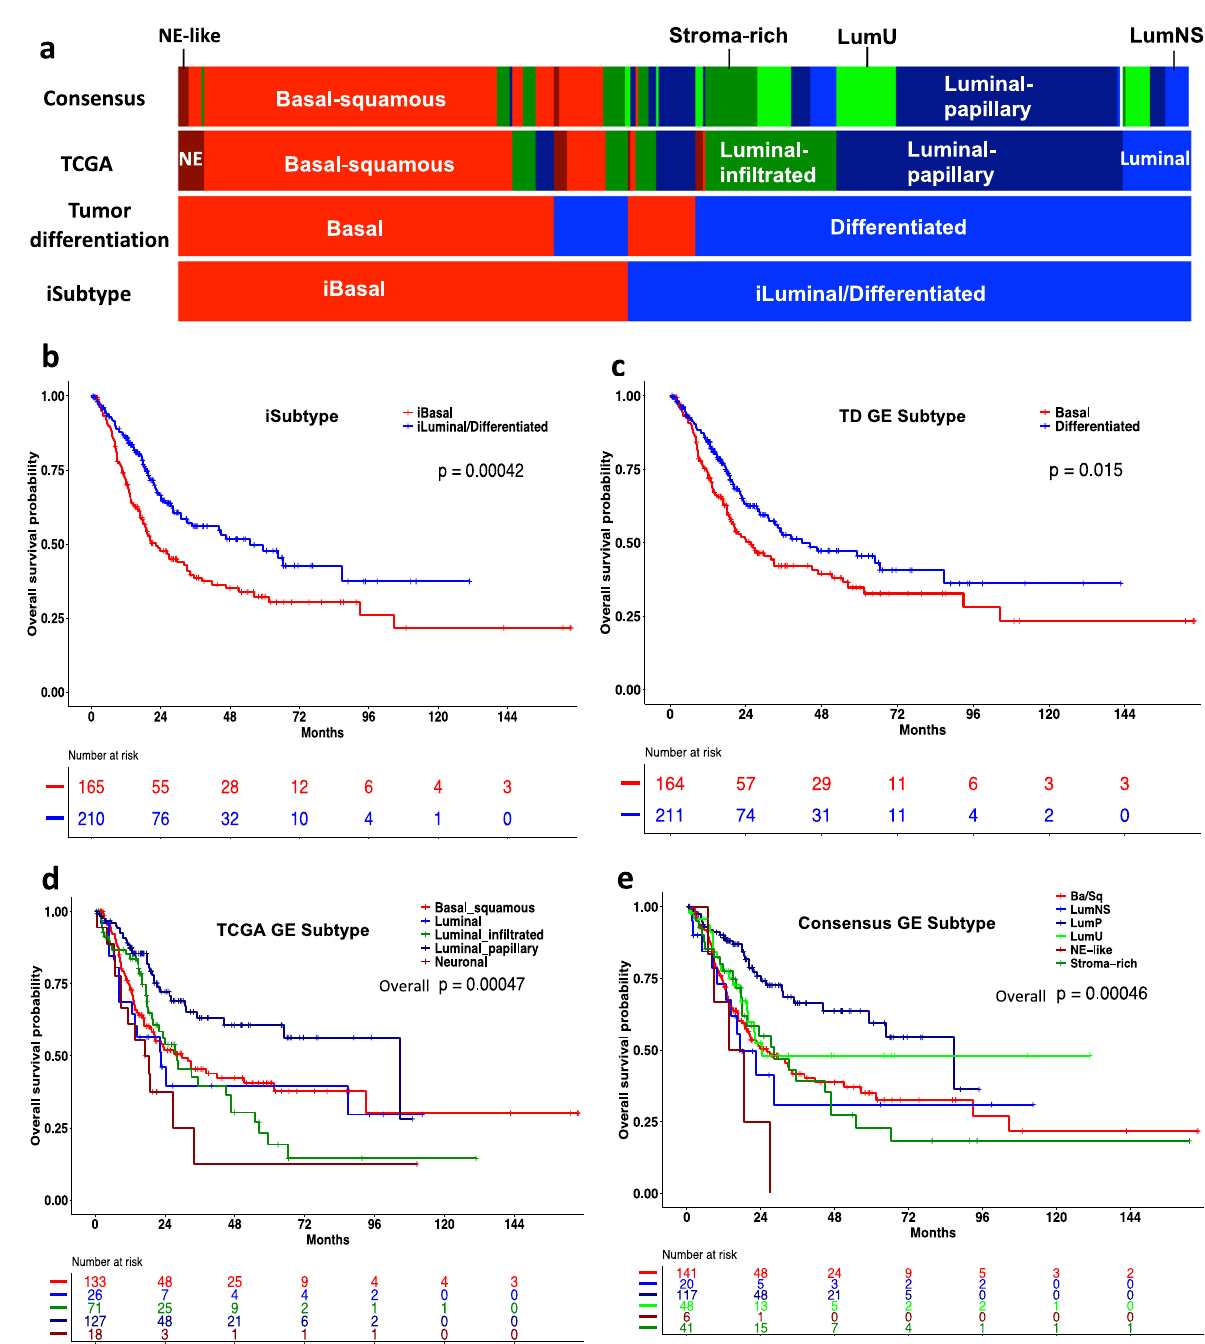
Fig. 2 Comparison of iSubtypes with other GE based subtypes in the TCGA cohort. a TCGA samples ( n = 388) colored according to the iSubtypes, TD, TCGA, and consensus GE subtypes, respectively. b Patient overall survival strati fi ed by iBasal and iLuminal/Differentiated subtypes. c Patient overall survival strati fi ed by the basal and differentiated subtypes de fi ned by the TD GE signature. d Patient overall survival strati fi ed by the TCGA GE subtypes. Luminal_papillary vs. the others: p < 0.0001. NE = neuronal. e Patient overall survival strati fi ed by the consensus GE subtypes. LumP vs. the others: p < 0.0001. Ba/Sq: basal/squamous; LumNS = luminal nonspeci fi ed; LumP = luminal papillary; LumU = luminal unstable; NE = neuroendocrine. Kaplan – Meier curves and log-rank test p -values shown on b – e are based on 375 non-NAC patients without missing